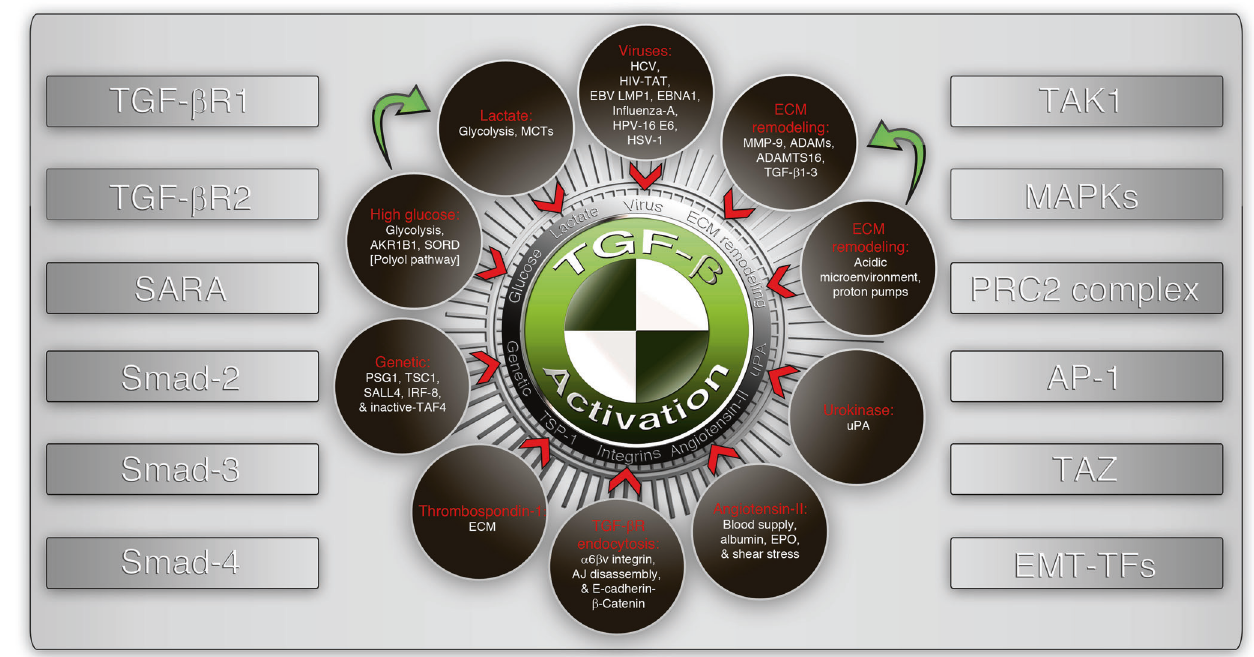
Fig. 3 Activators and signaling components of the TGF- β signaling pathway. A non-exhaustive list of activators of TGF- β signaling (shown in dark brown circles) where one activator may lead to the convergence with the other (green arrows). The downstream signaling receptors and signal transducers (left panel) and important downstream co-operative molecules regulating epithelial-mesenchymal transition (right panel) are listed as side panels. SARA Smad anchor for receptor activation, TAK1 TGF- β activated kinase-1, MAPKs mitogen-activated protein kinases, PRC2 polycomb-repressive complex-2, AP-1 activator protein-1 (Jun/Fos/Fra), EMT-TFs epithelial-to-mesenchymal transition regulatory transcription factors, MCTs monocarboxylate transporters, ECM extracellular matrix, EPO erythropoietin, AJ adherens